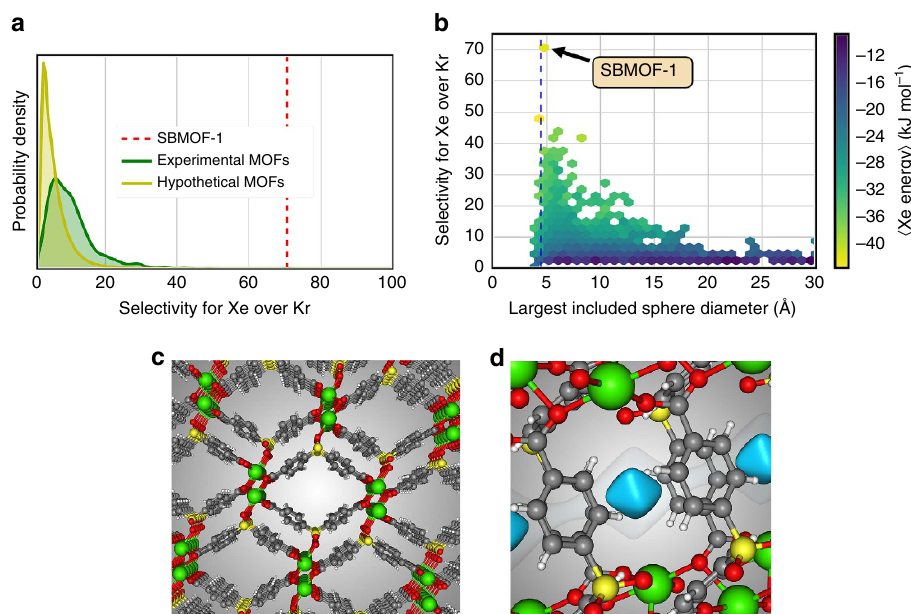
Figure 1 | Computational screening of MOFs for Xe/Kr separations at dilute conditions relevant to UNF reprocessing off-gas. We computed the Henry coefficients of Xe and Kr in B 125,000 MOF structures; the selectivity at dilute conditions is the ratio of Henry coefficients. ( a ) Distribution of simulated selectivities for experimentally synthesized (green) and hypothetical (yellow) MOF structures; vertical, dashed line is SBMOF-1 (KAXQIL in the Cambridge Structural Database (CSD)). ( b ) Histogram showing relationship between selectivity and pore size, with the largest included sphere diameter as a metric; colour shows average energy of Xe adsorption in that bin. SBMOF-1 (KAXQIL in CSD), with simulated selectivity 70.6 and largest included sphere diameter of 5.1Å, is indicated. Vertical, dashed line is the distance that yields the minimum energy in a Xe–Xe Lennard–Jones potential. ( c ) SBMOF-1 is composed of corner sharing, octahedrally coordinated calcium chains along the crystallographic b direction, which are connected by organic linkers, forming a one-dimensional nanoporous channel. ( d ) Side view. Shown are the calculated potential energy contours of a Xe atom adsorbed in the pore (blue surface, (cid:2) 32kJmol (cid:2) 1 ; white surface, 15kJmol (cid:2) 1